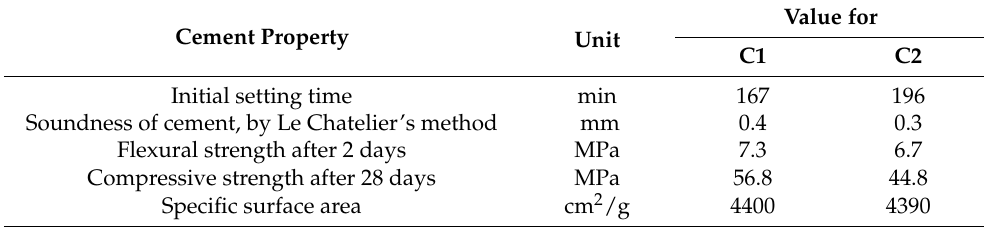
Table 3. Basic properties of